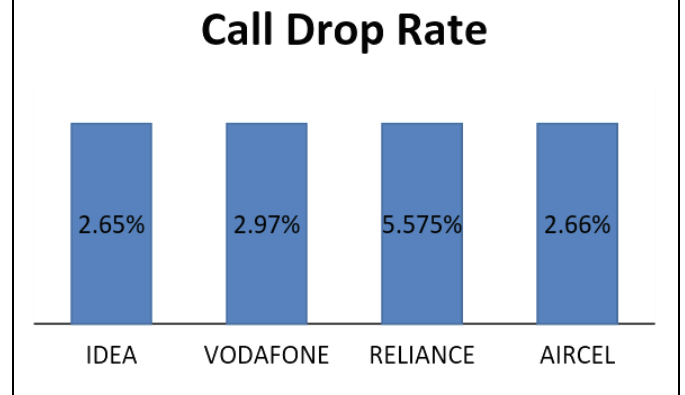
Fig. 2. Call drop rates of prominent telecom service providers